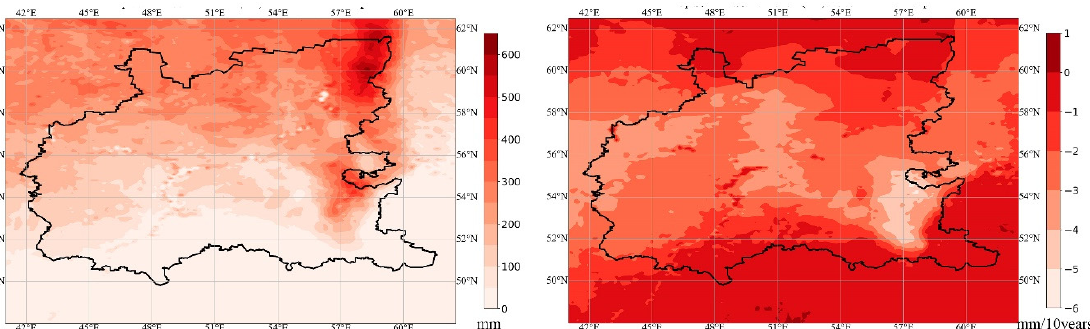
Figure 5. Spatial distribution of calculated annual runoff ( R ) (left map) and LTSC values of annual runoff (right map) in the Volga Federal District during 1979–2021.